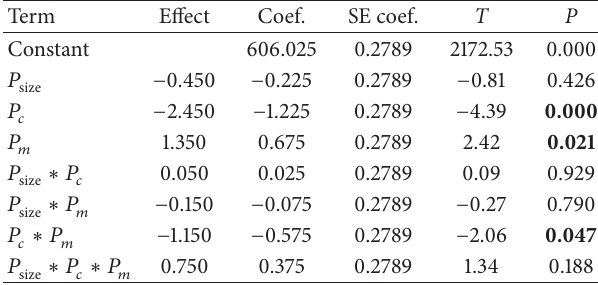
Table 7: Parameter